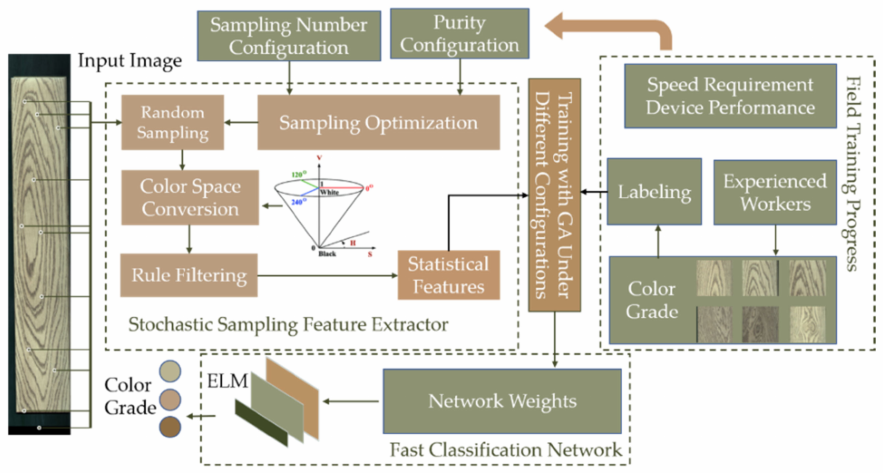
Figure 3. Workflow of the proposed online classification method of solid wood floors. ELM: extreme learning machine, GA: genetic